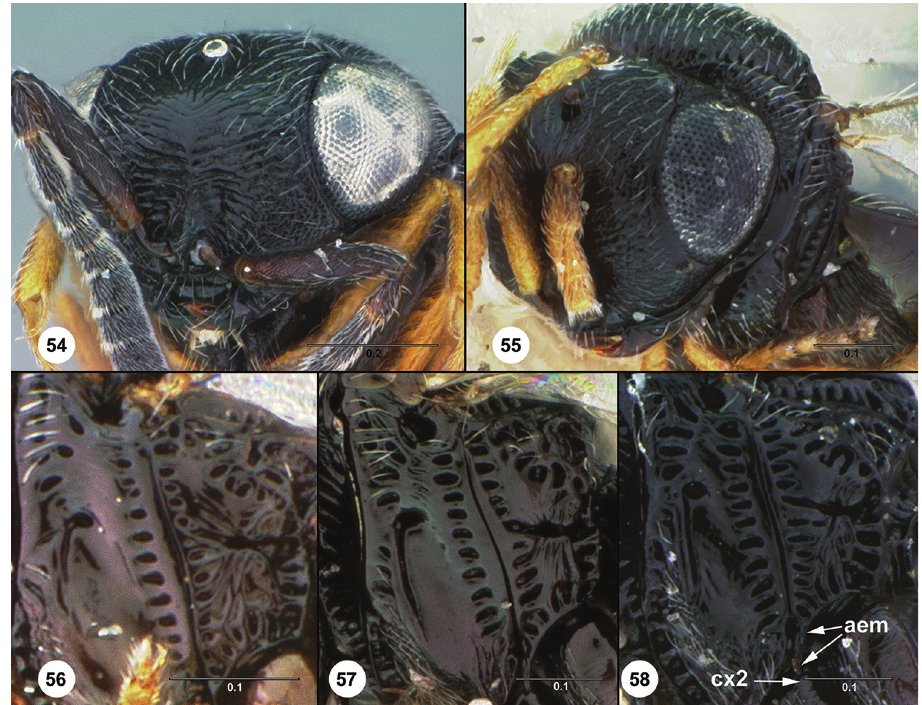
Figures 54–58. T. elasmuchae 54 female (OSUC 144486), head, anterior view 55 female paratype (USN- MENT00746982), head and mesosoma, anterolateral view 56 female paratype (USNMENT00746982), mesopleuron and metapleuron, lateral view 57 female (USNMENT00896150), mesopleuron and meta- pleuron, lateral view 58 female (USNMENT00916427), mesopleuron and metapleuron, lateral view. Scale bars in millimeters.